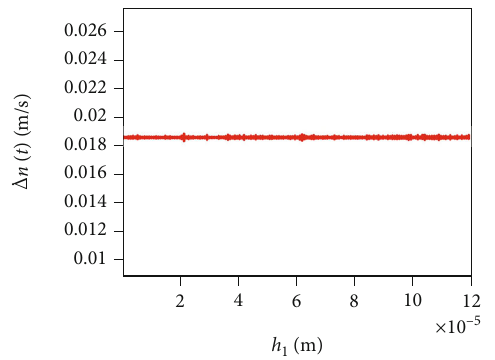
Figure 15: Bifurcation diagrams with changes in the uniform wear when the misalignment in the x direction is 3 : 32 × 10 − 4 m.